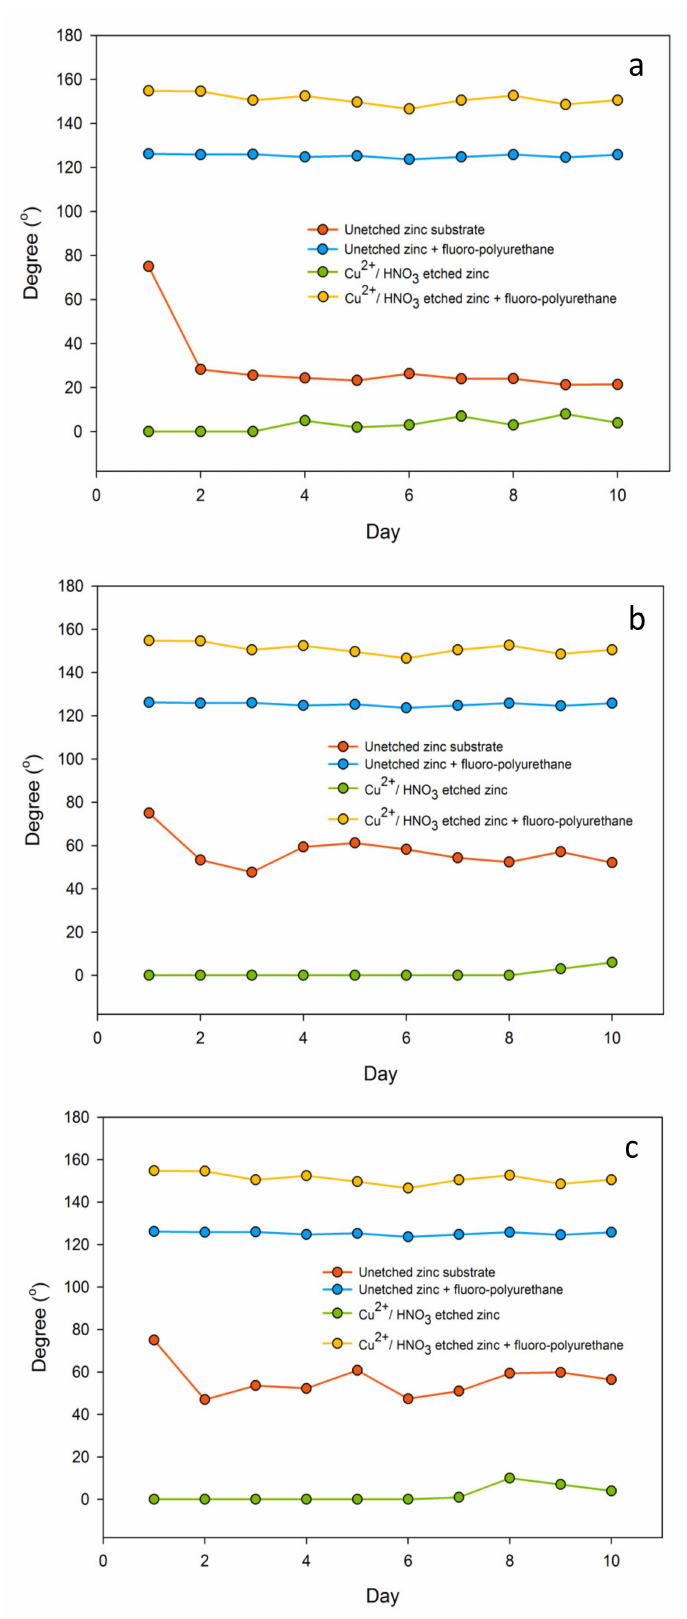
Figure 7. Surface wettability variability for continuous 10 days in three di ff erent chemicals ( a ) 8.0 wt % hydrochloric acid (acid), ( b ) 8.0 wt % sodium hydroxide (alkaline), and ( c ) 40.0 wt % sodium chloride (saline)